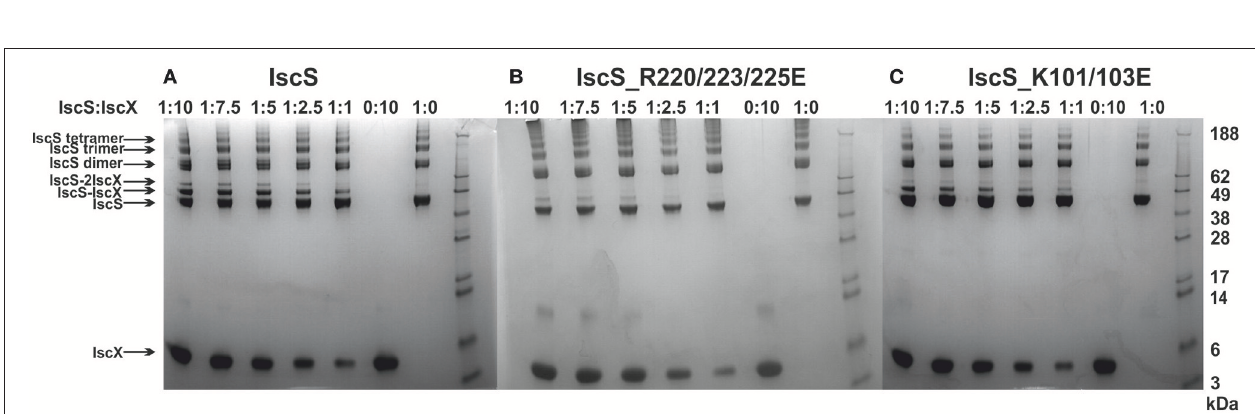
FIGURE 4 | Cross-linking experiments to identify the interacting sites on IscX and IscS using different relative concentrations of IscS and IscX. (A) Experiments using wild-type IscS (8 µ M) and IscX at molar ratios 1:10, 1:7.5, 1:5, 1:2.5, and 1:1 from left to right. The last two lanes on the right are the controls carried out using isolated IscS and IscX. As expected the IscS dimer disassembles in SDS and runs as a monomer of ca. 45kDa. (B) The same as in A but with the IscS_R220/223/225E mutant. (C) The same as in A but with the IscS_K101/105E mutant. The markers are indicated on the right.